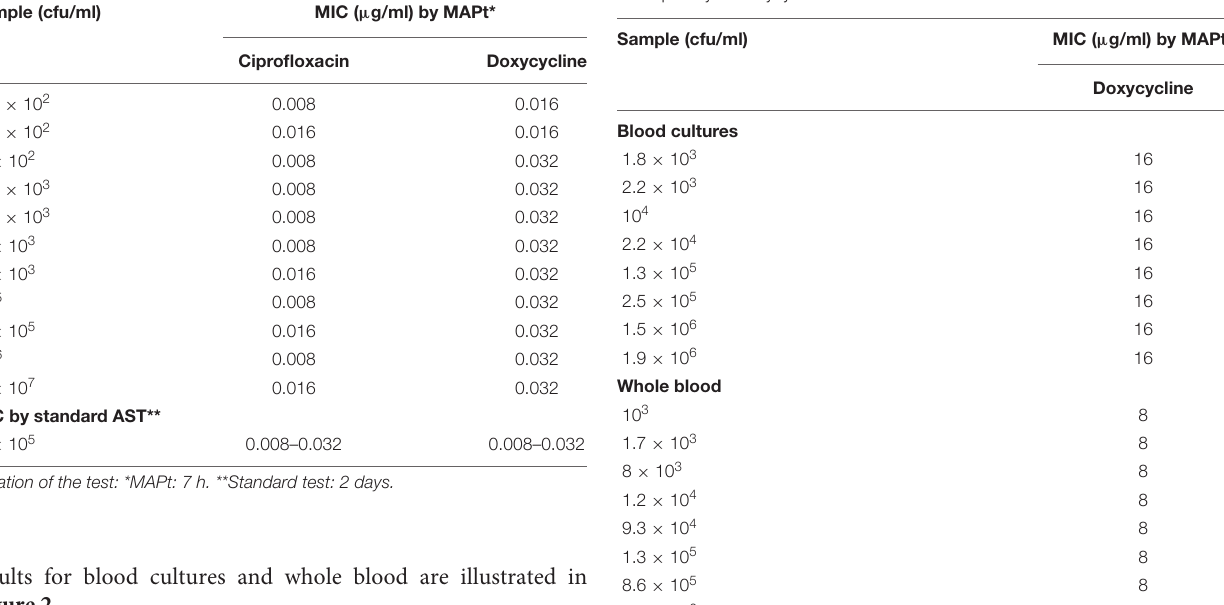
TABLE 6 | MIC values for doxycycline obtained by MAPt of blood cultures and whole blood samples inoculated with Y. pestis derivatives with reduced susceptibility to doxycycline.